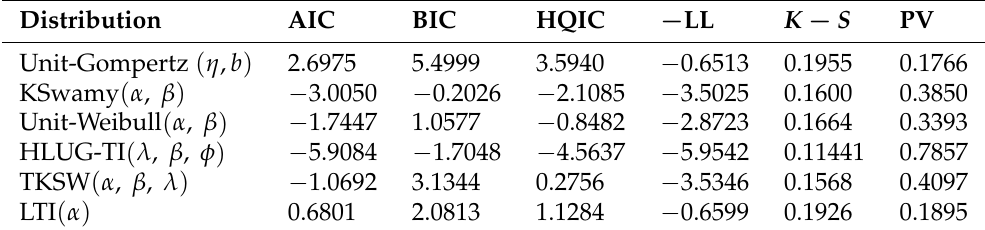
Table 4. Values of the considered goodness-of-fit measures for Data I.